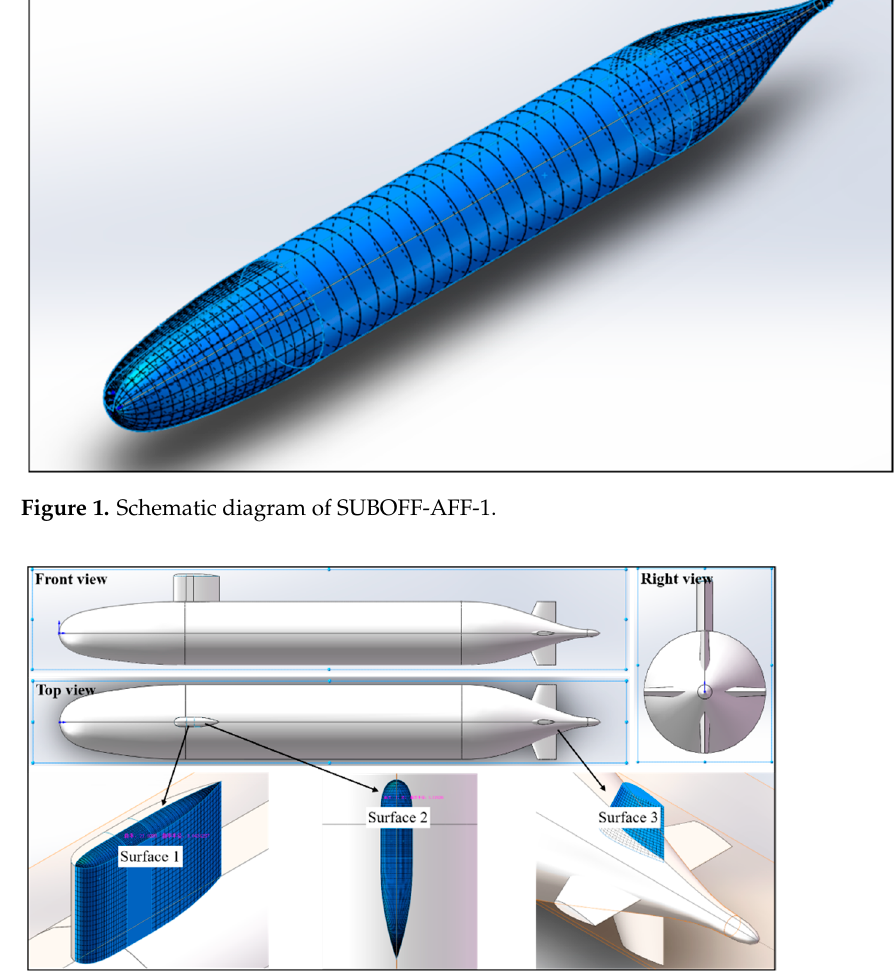
Figure 2. Schematic diagram of SUBOFF-AFF-8.